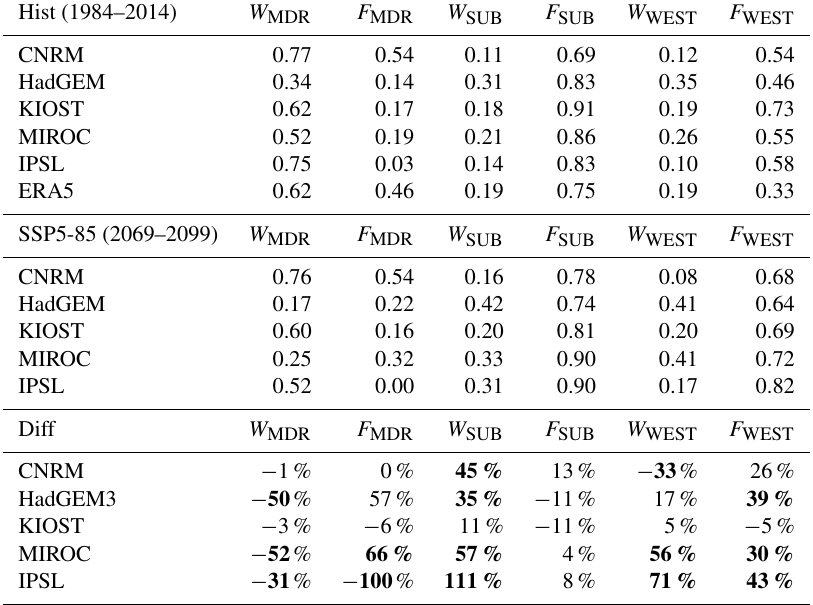
Table 3. Tabulated values of the terms of the right-hand side of Eq. (3) for the historical run (top), the future run under SSP5-85 (middle), and the fractional change (bottom) for the five selected CMIP6 models. Bolded differences represent statistical significance at the 95% level.